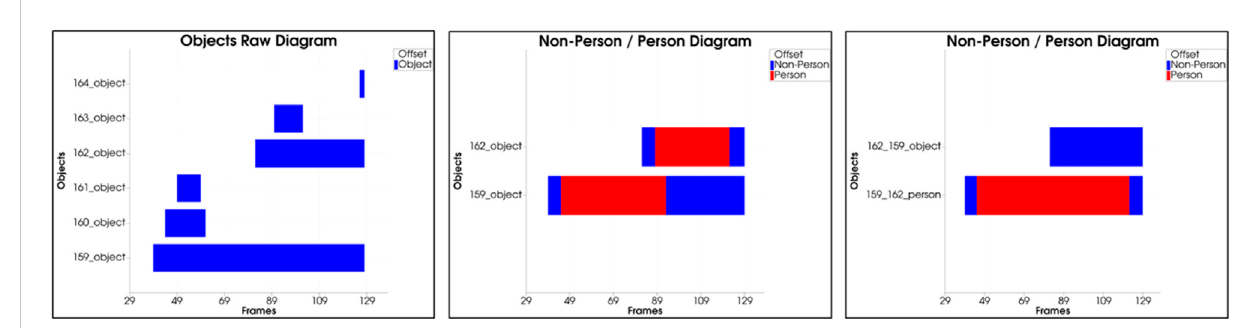
FIGURE 6 (left)Input:distributionofrawobjectsovertheentiresequence,(center)Filtering:removalofallsmallunde fi nedobjects,(right)Optimization:object decompensation and reordering by